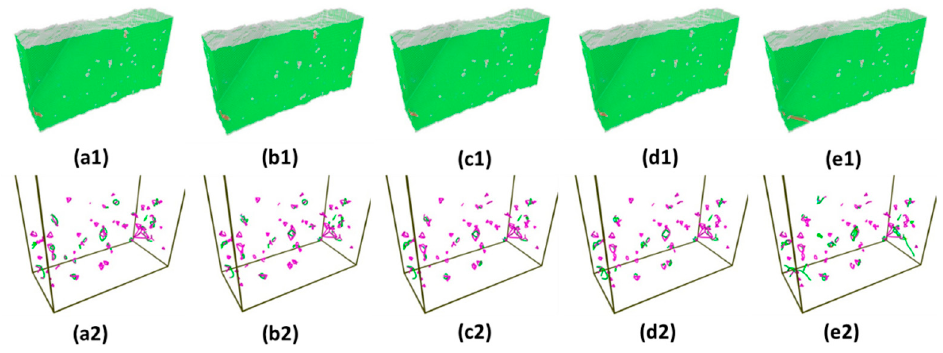
Figure 19. Snapshots of initial atomic structures and distributions of dislocations before indentations at various strain level ( a1 , a2 ) 0%, ( b1 , b2 ) 25%, ( c1 , c2 ) 50%, ( d1 , d2 ) 75%, and ( e1 , e2 ) 100%.